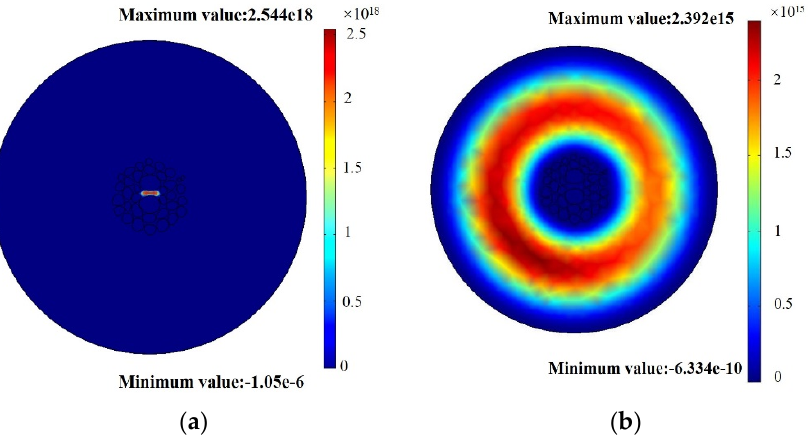
Figure 6. ( a ) The fundamental mode; ( b ) the cladding mode of microstructure fibers.